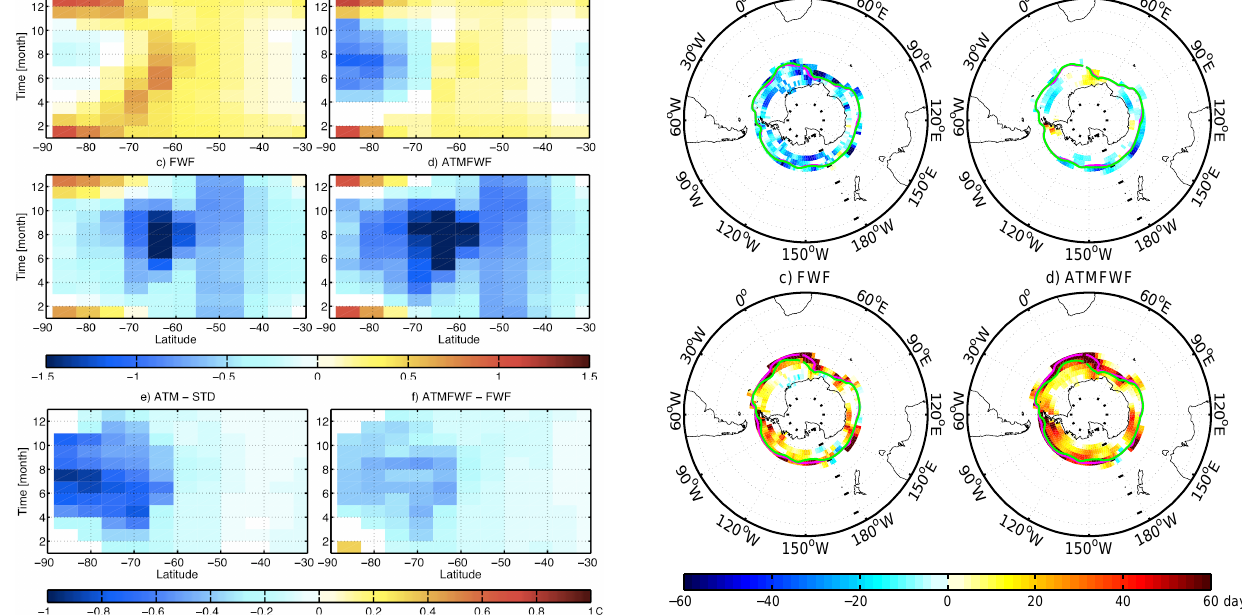
Fig. 6. Difference of sea ice duration between 8 and 10ka (8ka minus 10ka) expressed in days for (a) STD, (b) ATM, (c) FWF (d) ATMFWF. Pink (green) lines show the sea ice extent during September at 8ka (10ka). Colored areas correspond to differences significant at the 99% level according to a Student t